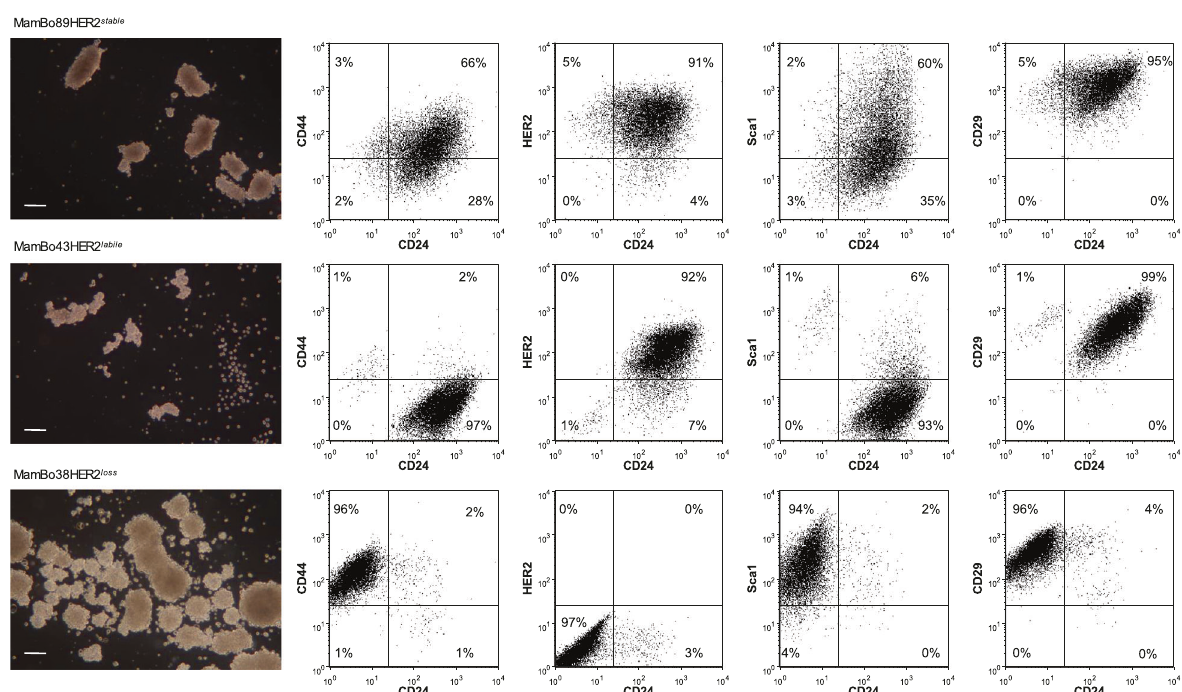
Fig. 2 Stemness pro fi le of MamBo cell lines. A Dark- fi eld micrographs of mammosphere formation assay. White bar corresponds to 200 μ m. Mean number of mammospheres ± SEM ( n = 4): MamBo89HER2 stable , 23 ± 1; MamBo43HER2 labile , 17 ± 1; MamBo38HER2 loss , 69 ± 9; MamBo38HER2 loss vs MamBo89HER2 stable and MamBo43HER2 labile cell lines, p < 0.01 by Student ’ s t -test. B Expression of HER2 and stemness markers CD24, CD44, Sca1 and CD29, in cells cultured under 2D-adherent conditions, measured by cyto fl uorimetric analysis.